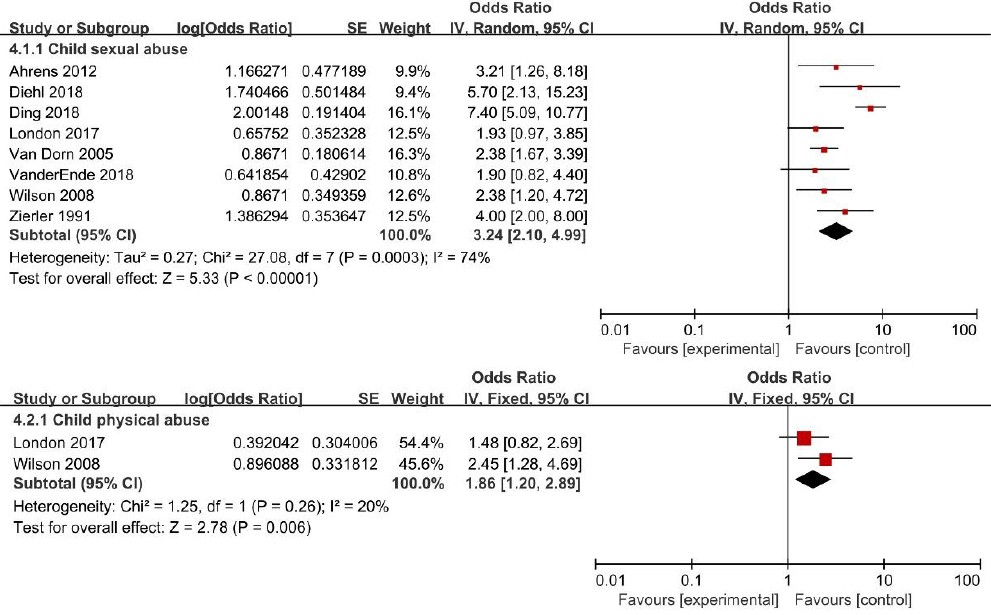
Figure 5. Forest plot for subtypes of childhood maltreatment and risk of having transactional sex.